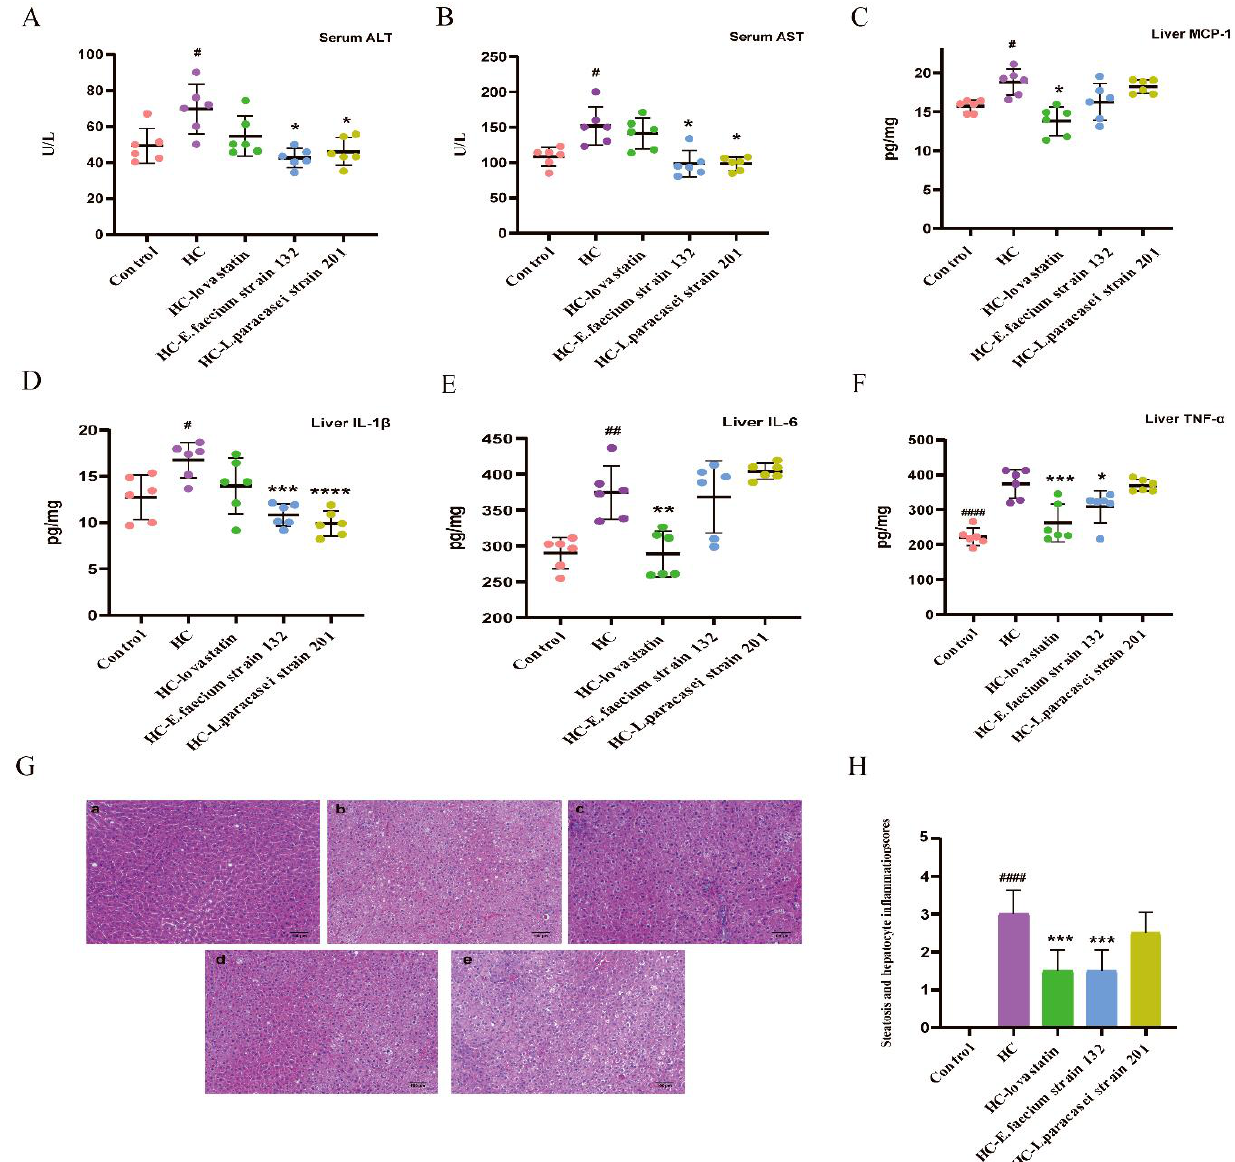
Figure 2. Screening strains improved liver injury in hypercholesterolemia rats. ( A ) The level of serum glutamic pyruvic transaminase (ALT). ( B ) The level of serum glutamic oxalacetic transaminase (AST). ( C ) The level of liver monocyte chemotactic protein-1 (MCP-1). ( D ) The level of liver interleukin-1β (IL-1β). ( E ) The level of liver interleukin-6 (IL-6). ( F ) The level of liver tumor necrosis factor-α (TNF-α). ( G ) Hematoxylin-eosin (H&E) staining of liver; (a) control group, (b) HC group, (c) HC-lovastatin group, (d) HC- E. faecium strain 132 group, (e) HC- L. paracasei strain 201 group. ( H ) Steatosis and hepatocyte inflammation scores. p -values were determined using a one-way ANOVA with Tukey’s test for post-hoc analysis, n = 6. Significant differences between the HC group versus control group are indicated as # p < 0.05, ## p < 0.01, #### p < 0.0001. Significant differences in the HC-lovastatin, HC- E. faecium strain 132 or HC- L. paracasei strain 201 group versus HC group are indicated as * p < 0.05, ** p < 0.01, *** p < 0.001, **** p < 0.0001.